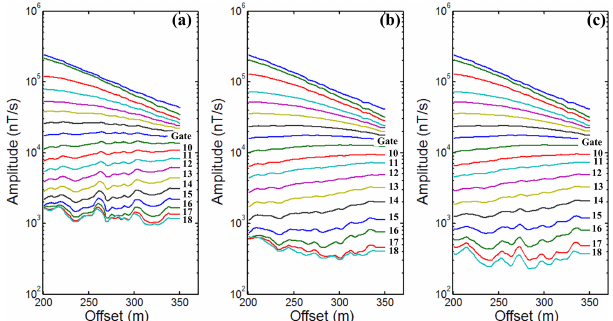
Figure 7. Anomaly curve profile image generated from field data by different methods. (a) The profile of raw data; (b) the profile of data using the wavelet-based method; (c) the profile of data using the EEMD-AF method. Because the duration of raw data was 60s and the flight speed of the UAV was 2.5ms − 1 , the offset distance was 150m. The vertical coordinates are changed to logarithmic format in order to facilitate the display of detail of each gate in each